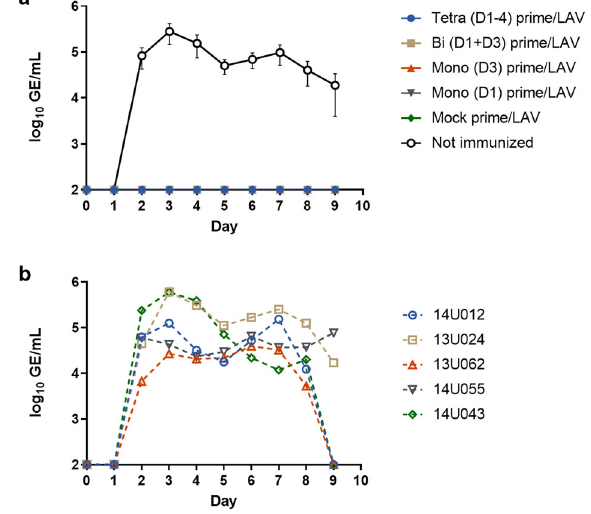
Fig. 9 Viremia resulting from the challenge of vaccinated and unvaccinated control animals with wild-type DENV-2. All vacci- nated animals were protected from detectable viremia upon challenge. All unvaccinated control animals had detectable DENV- 2 viremia lasting from day 2 until day 8 or beyond. Data are presented as log 10 -transformed genome-equivalents (GE)/mL. a Geometric mean viremia by the group; error bars show the standard error of the means. b Viremia curve of each animal in the unvaccinated control group shown in panel ( a